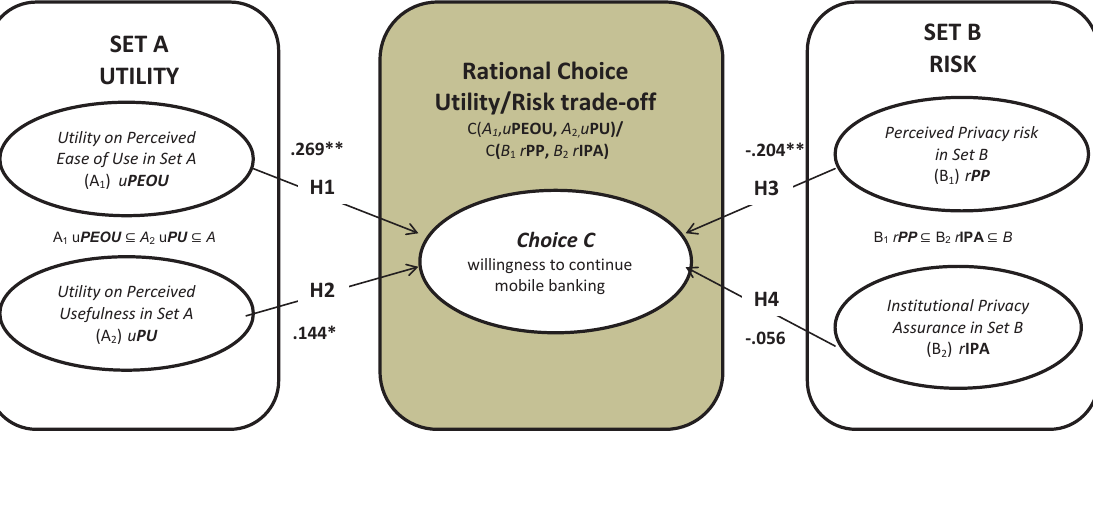
RATIONAL CHOICE CONCEPTUAL MODEL SHOWING EMPIRICAL